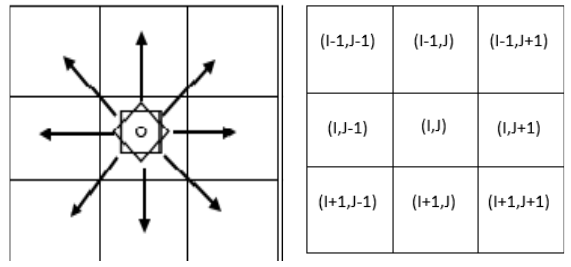
Fig. 6. An ant searching the surrounding